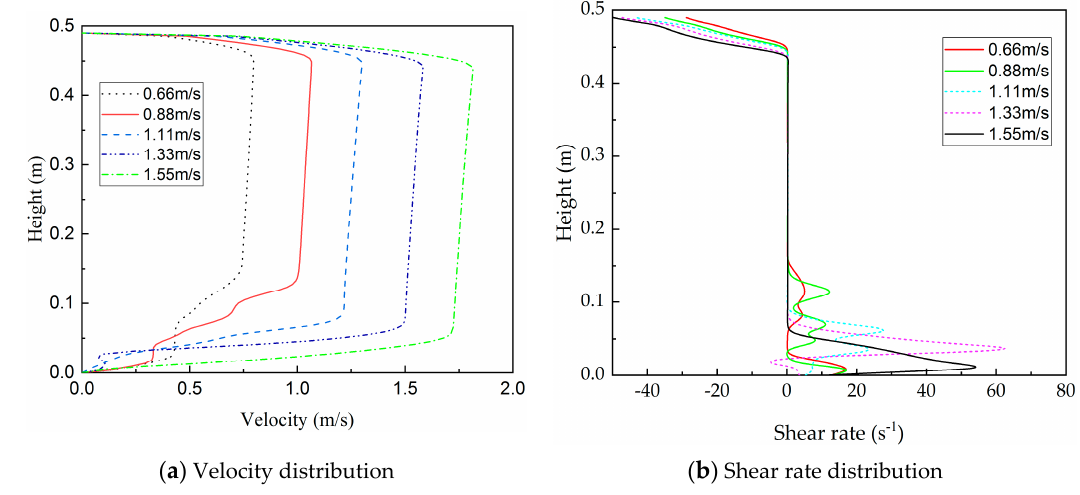
Figure 18. Velocity distribution and shear rate distribution in section A-A ( α = 40°).